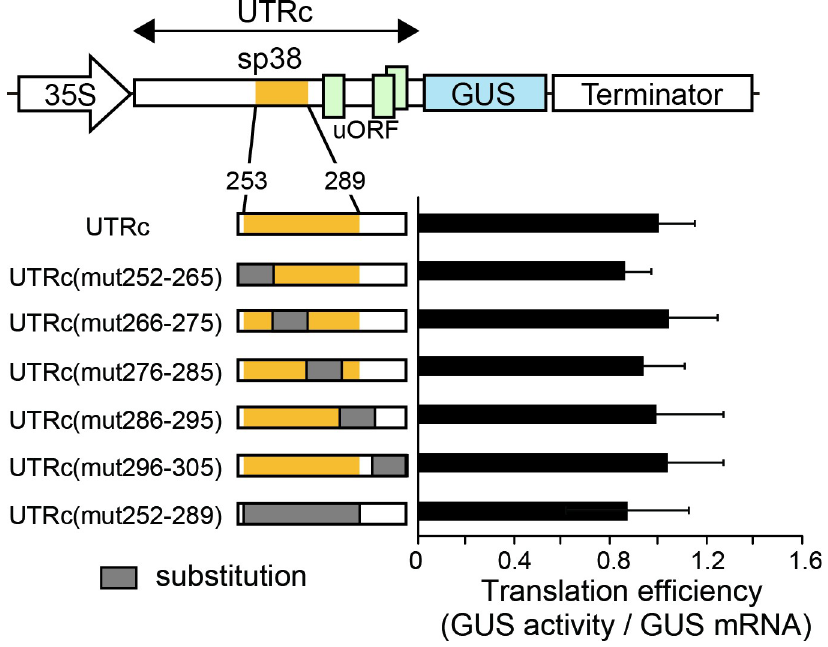
Fig 2. Translational efficiency of the UTRc containing modified sp38 regions. Regions of substitution in sp38 are indicated by shaded boxes (left panel). Numbers in the names of mutant genes indicate the regions of nucleotides that are substituted by the complementary ones. Right panel indicates the relative GUS activities normalized against the GUS mRNA, whose amount was estimated by real-time qRT–PCR. The value of the GUS activity with the wild-type UTRc was set as 1.0. The results represent the means of three independent experiments. Error bars indicate the SD (n = 3).